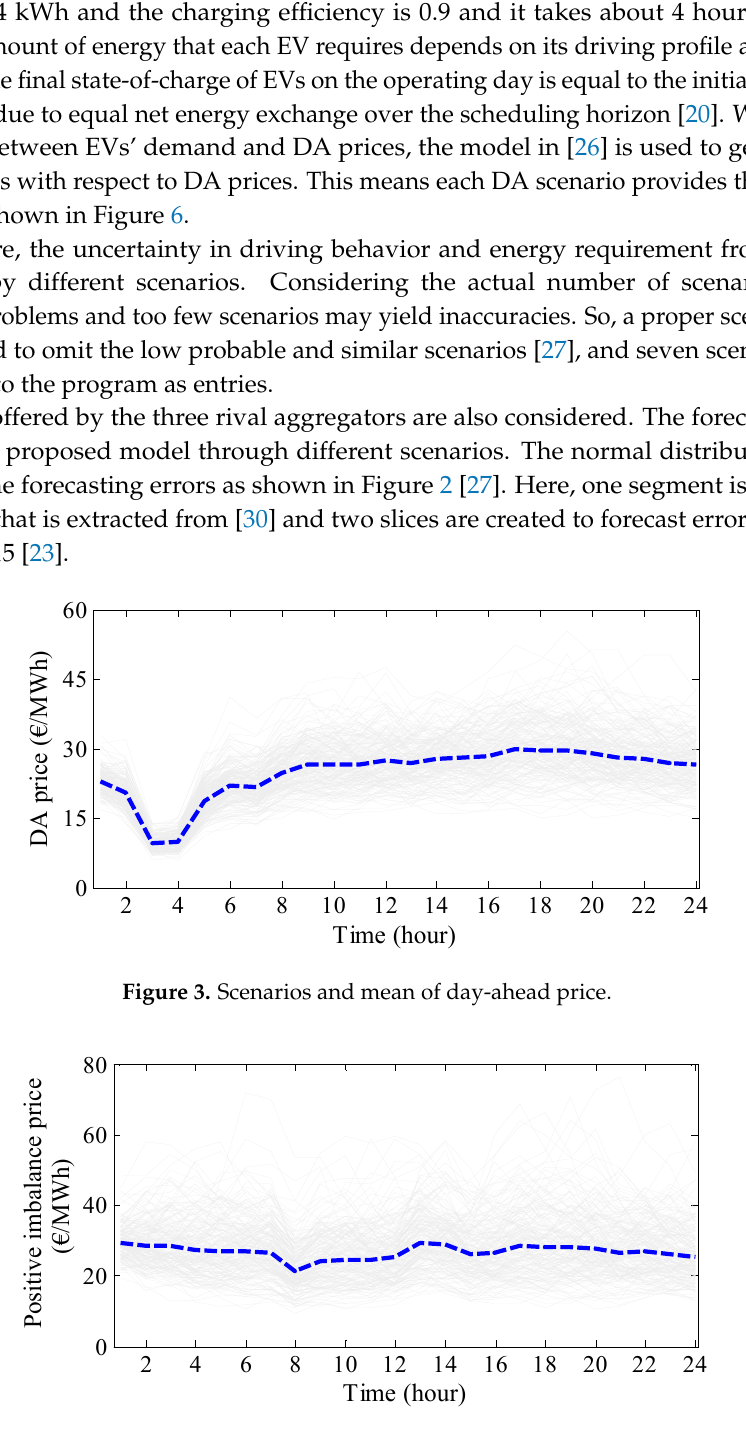
Figure 5. Scenarios and mean of negative imbalance price. Figure 6. Scenarios of Electric vehcles’ demand. The cost of modeling the reluctance of EV owners to change their aggregator is neglected )0( ,   ss K